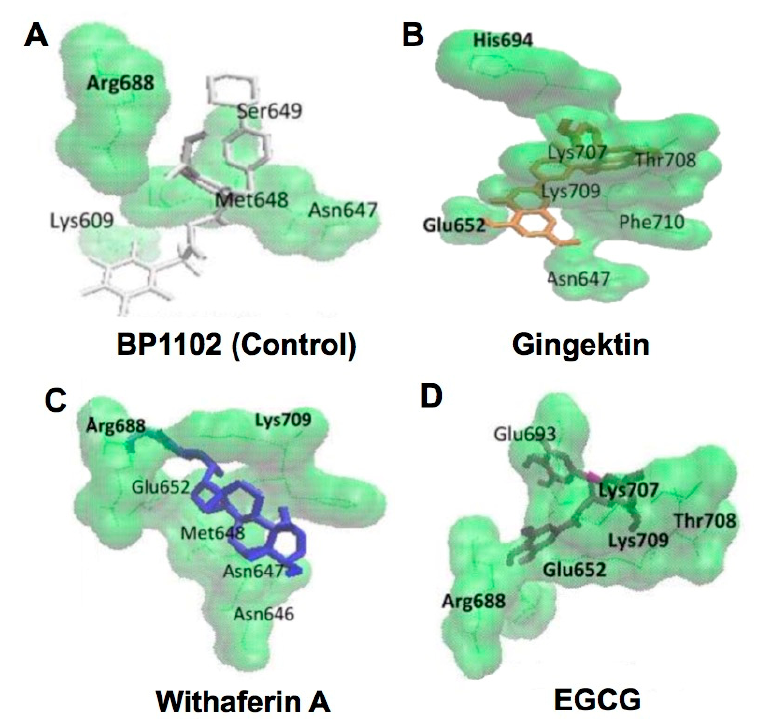
Figure 6. CMDA of binding interactions of selected compounds including EGCG with the DH2 domain of STAT3. ( A ) BP1102; ( B ) gingektin; ( C ) withaferin A; ( D ) EGCG. The amino acids with hydrogen bond interactions are shown in bold. Reproduced from [40] under a Creative Commons Attribution 3.0 License. PII: